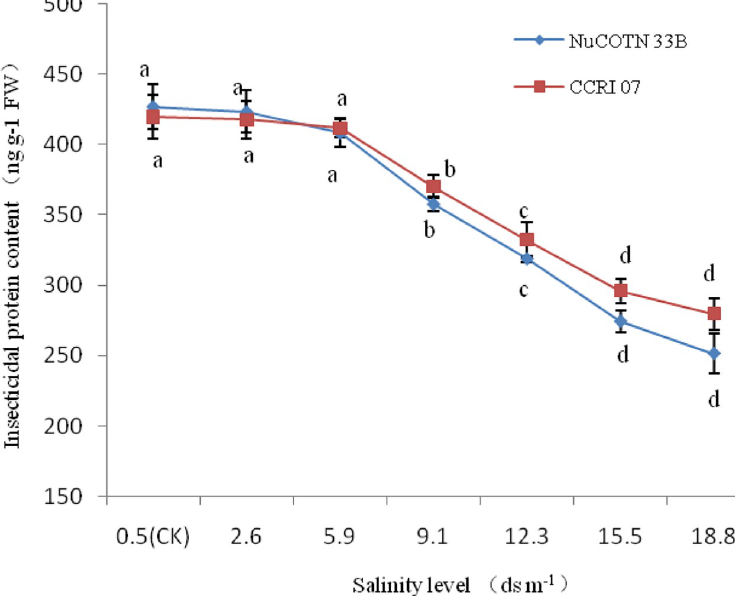
Fig 1. Effects of soil salinity on insecticidal protein content in square of two cotton cultivars (mean ± SE, n = 4). Different letters represent significant differences (Duncan multiple range test, P < 0.05).